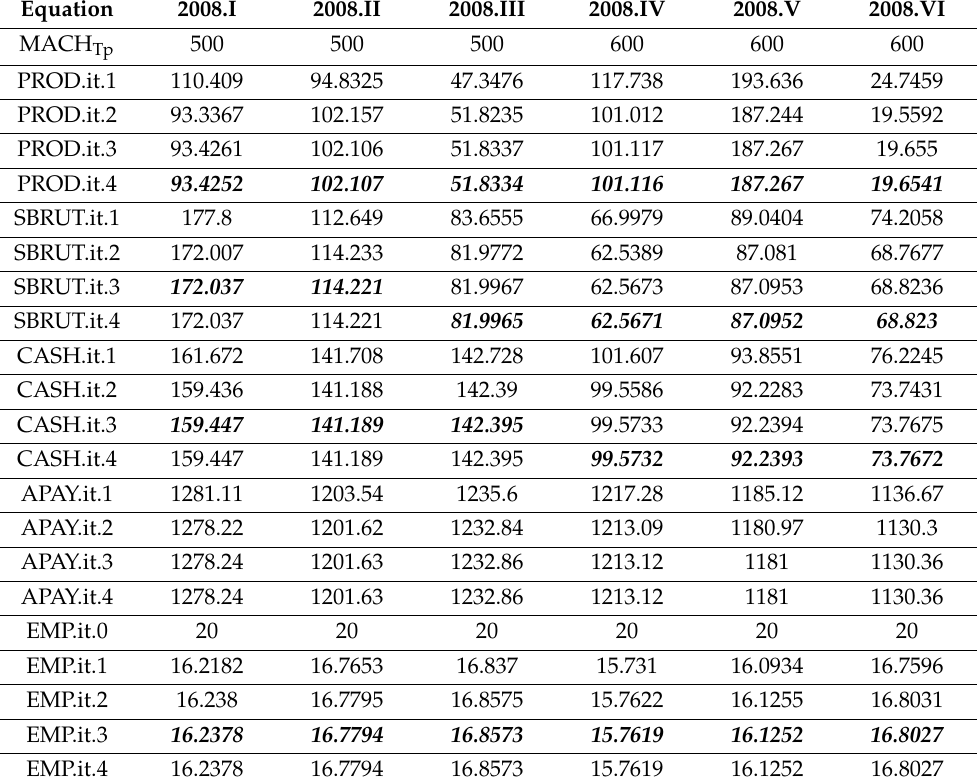
Table 3. Forecasts from the structural-form system of interdependent equations—the path to conver- gent forecasts, with consideration of an increase in the value of machinery and equipment.